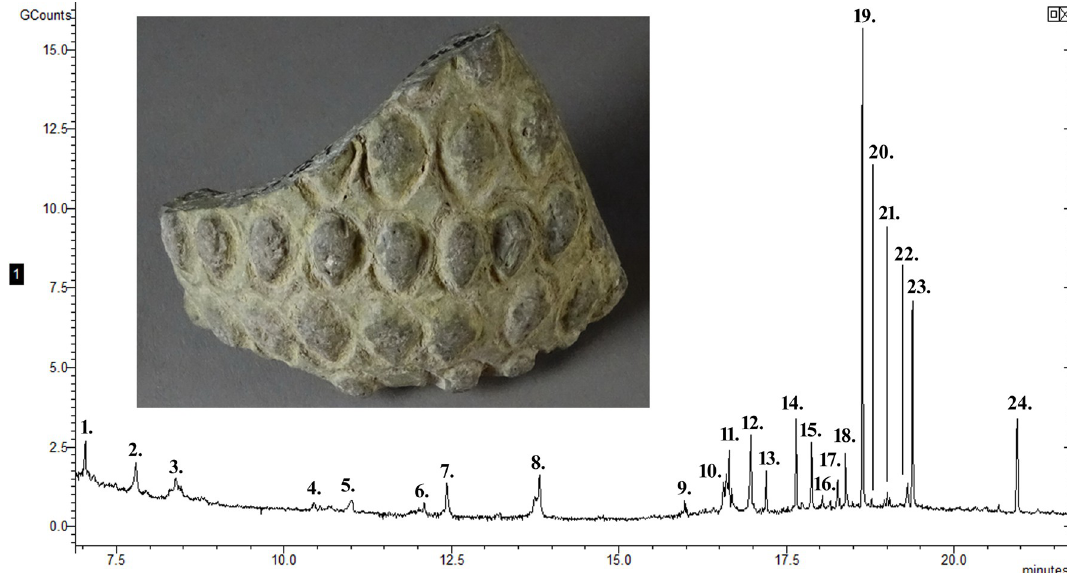
Fig 4. The chromatogram of the residue from sphero-conical sherd 744. The peaks identify compounds 1—methylmalonic acid, 2–2-hydroxytetradecane, 3–2-cyclohexen-1-ol, 4–2-acetylresorcinol, 5—unidentified, 6—benzoic acid, 7–2-(4-methoxyphenyl)-2- (4-hydroxyphenyl)-propane, 8–1-bromo-4-iodo-benzene, 9—adipic acid, 10–3-methoxycinnamic acid, 11–4-methoxycinnamic acid, 12—cyclohexyl, ethyl phthalate, 13—lauric acid, 14—azelaic acid, 15—myristic acid, 16—sebacic acid, 17—pentadecylic acid, 18— cetyl alcohol, 19—palmitic acid, 20—dodecanoic acid, 2,3-bis(acetyloxy)propyl ester, 21—margaric acid, 22—stearyl alcohol, 23— stearic acid, 24 - 17a-ethyl-3.beta.-methoxy-17a-aza-D-homoandrost-5-ene-17-one. Sample 744 was analysed at a later date than the other three samples and the column length was different resulting in a slight shift in retention